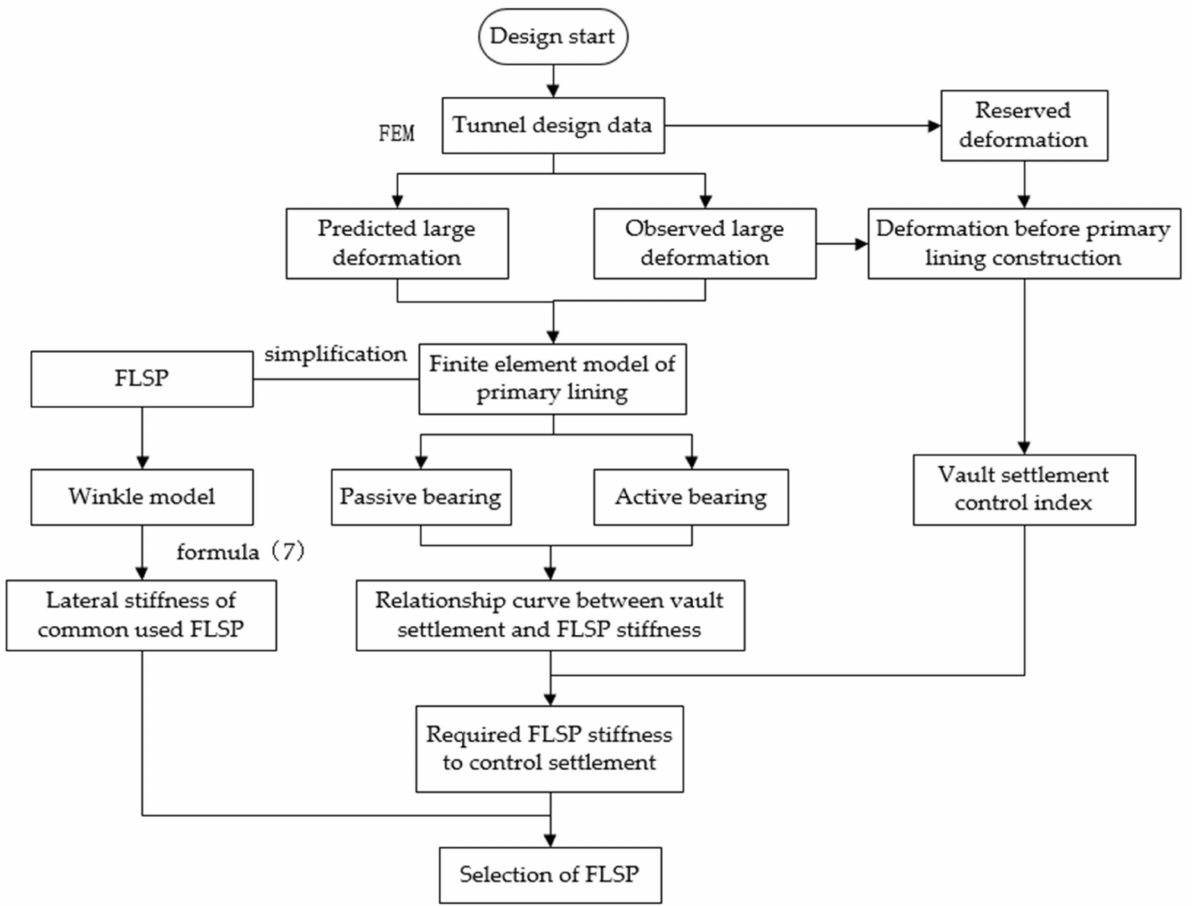
Figure 11. Flow chart of design optimization of FLSP.